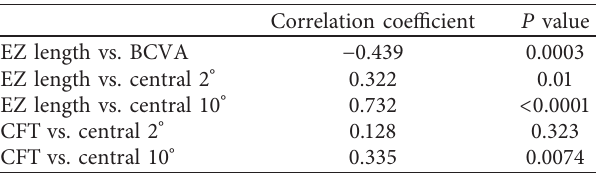
Table 2: Correlations between preoperative retinal constructions and postoperative visual acuity and postoperative retinal sensi- tivities ( n � 62).